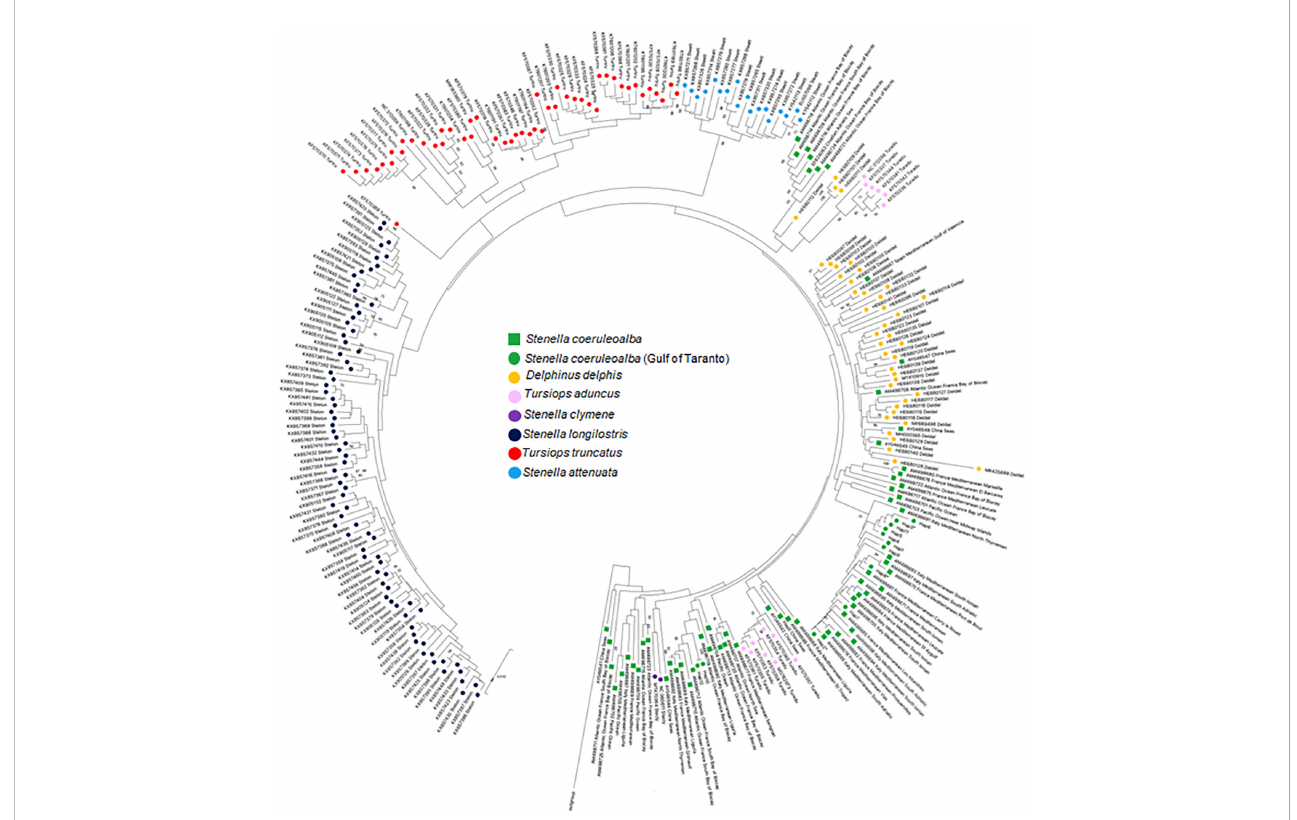
FIGURE 4 NJ tree inferred from Delphinidae D- loop sequences. Evolutionary analyses were conducted in MEGA X (Kumar et al., 2020). The optimal tree, with the sum of branch length = 0.44828118 is shown. The tree is drawn to scale, with branch lengths in the same units as those of the evolutionary distances used to infer the phylogenetic tree. The evolutionary distances were computed using the p-distance method (Nei and Kumar, 2000) and are in the units of the number of base differences per site. This analysis involved 76 nucleotide sequences. All ambiguous positions were removed for each sequence pair (pairwise deletion option). There was a total of 632 positions in the fi nal dataset. Every species is highlighted with a different colored circle to enhance the distribution on the phylogenetic tree. S. coeruleoalba of the Gulf of Taranto and of other areas were highlighted with different shape but the same color. The haplotype sequences identi fi ed in the Gulf of Taranto are highlighted with a red circle. Some of them (Hap-2, Hap-3 e Hap-8) are marked with an asterisk to indicate that their presence has also been documented in other